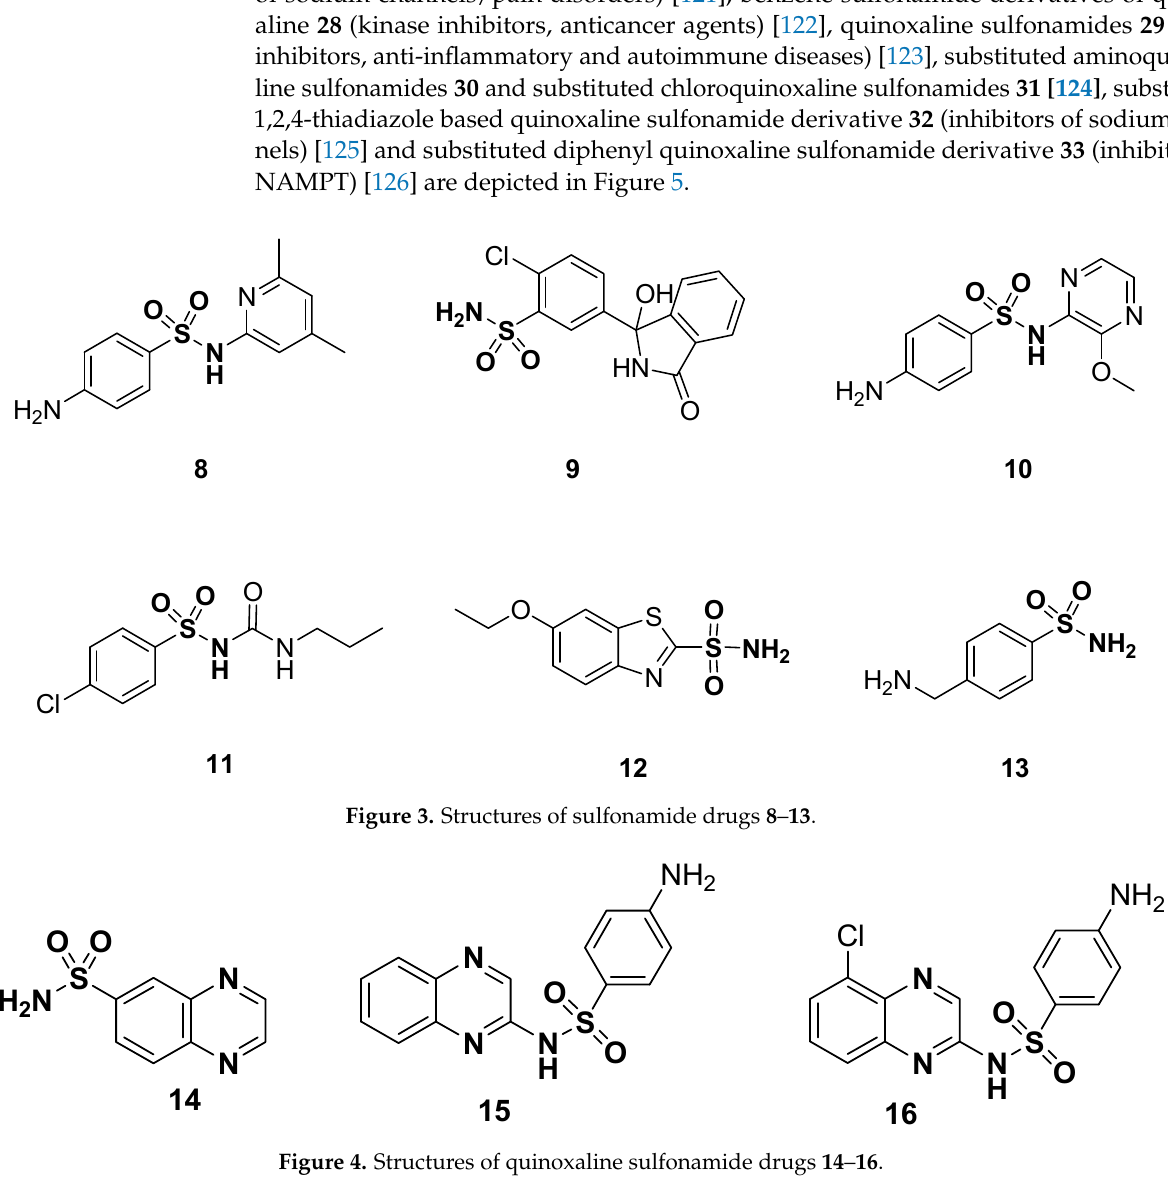
Figure 4. Structures of quinoxaline sulfonamide drugs 14–16.